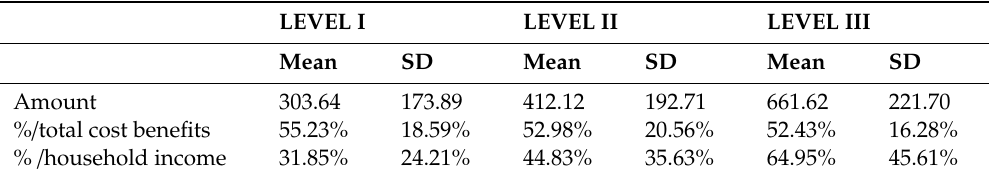
Table 5. Dependent care OOP payments by